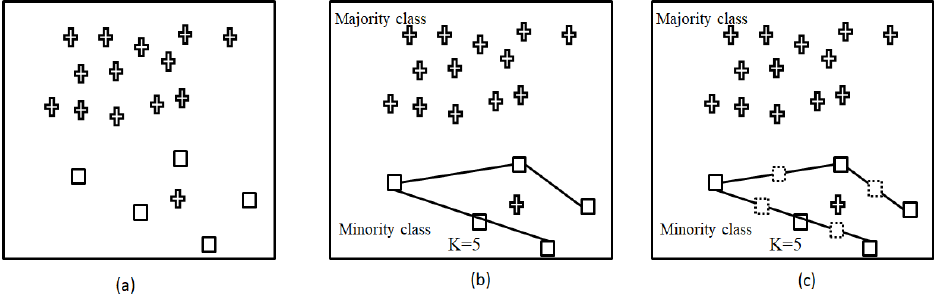
Figure 2. An example of resampling process of SMOTE. ( a ) Minority instances of the imbalanced data ( b ) Select five nearest neighbors ( c ) Generated two neighbors along the line segments.